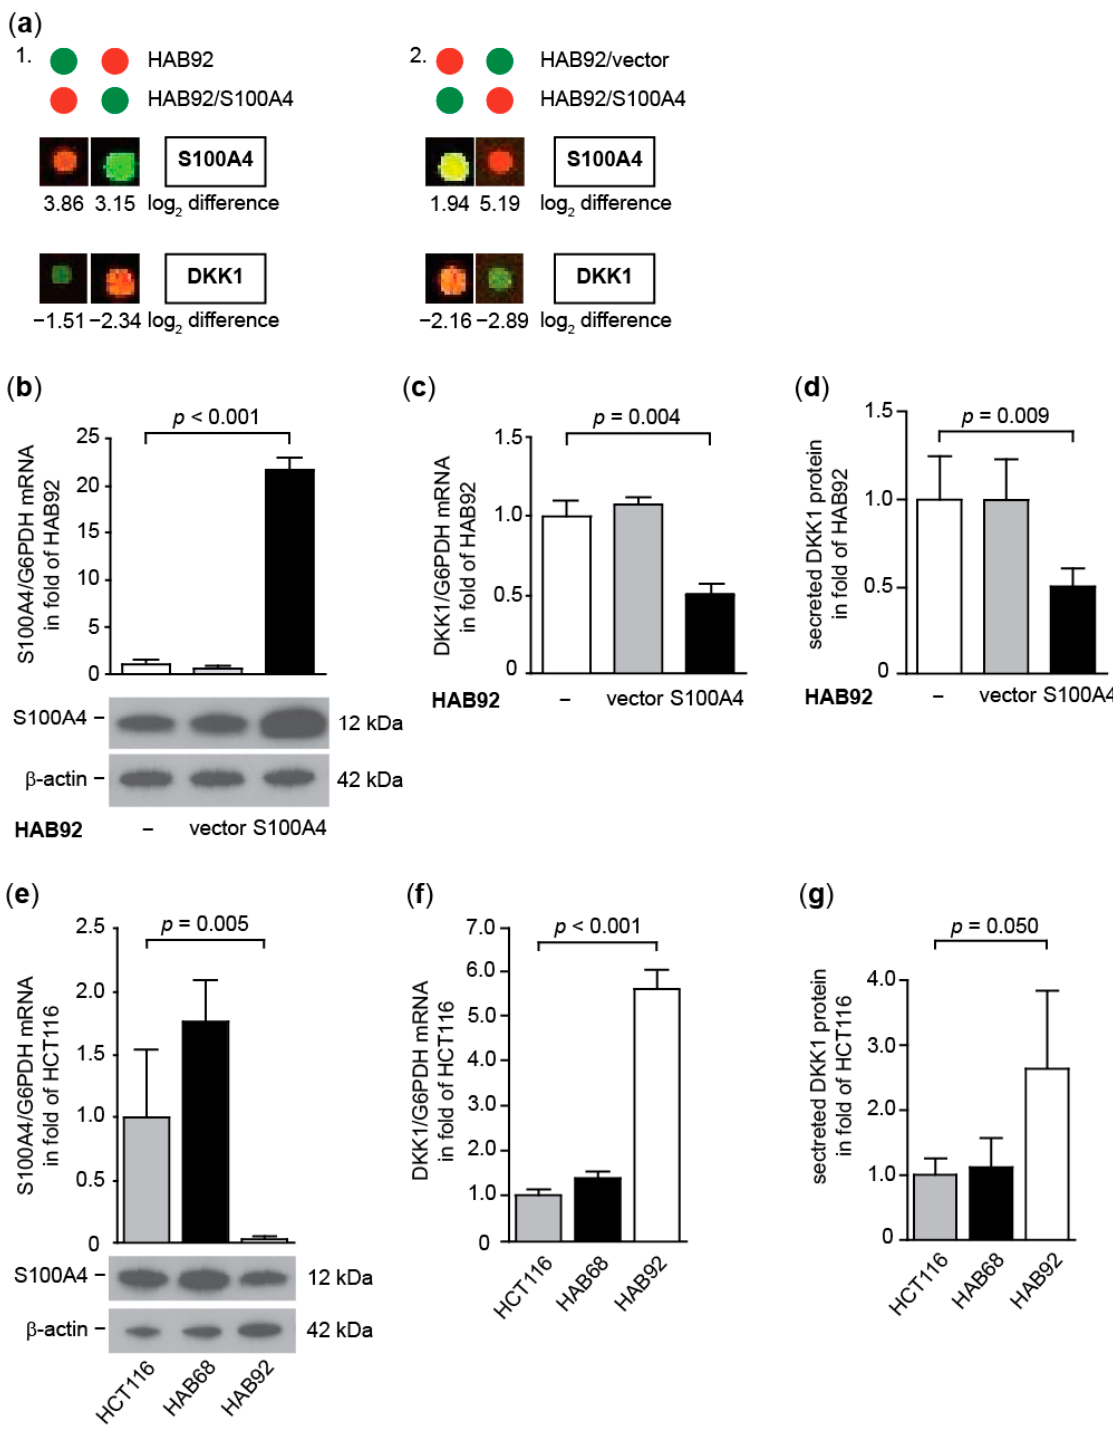
Figure 2. S100A4-induced expression alterations of DKK1 in CRC cell lines HCT116, HAB92, and HAB68. ( a ) Increased S100A4 expression and decreased DKK1 expression in HAB92/S100A4 cells vs. HAB92 cells (part 1) and HAB92/S100A4 cells vs. HAB92/vector cells (part 2). ( b ) Overexpression of S100A4 in HAB92/S100A4 cells on mRNA and protein level. Down-regulation of DKK1 mRNA expression ( c ) and of extracellular DKK1 ( d ) in HAB92/S100A4 cells. ( e ) S100A4 expression in HCT116, HAB68, and HAB92 cells on mRNA and protein levels; lowest S100A4 expression in HAB92 cells. Differential expression of DKK1 in HCT116, HAB68, and HAB92 cells on mRNA ( f ) and extracellular protein ( g ) levels; highest expression in HAB92